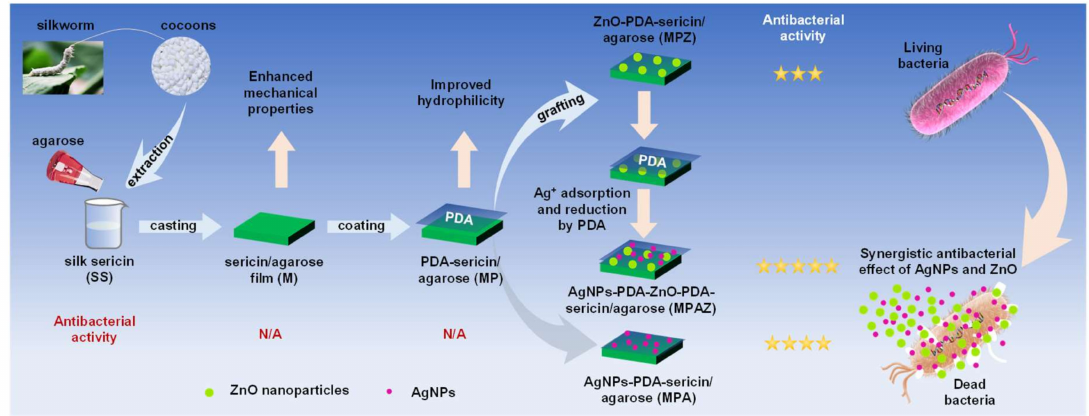
Figure 1. Preparation of AgNPs-PDA-ZnO-PDA-SS/AG (MPAZ) film with enhanced mechanical performance and antibac- terial activity.